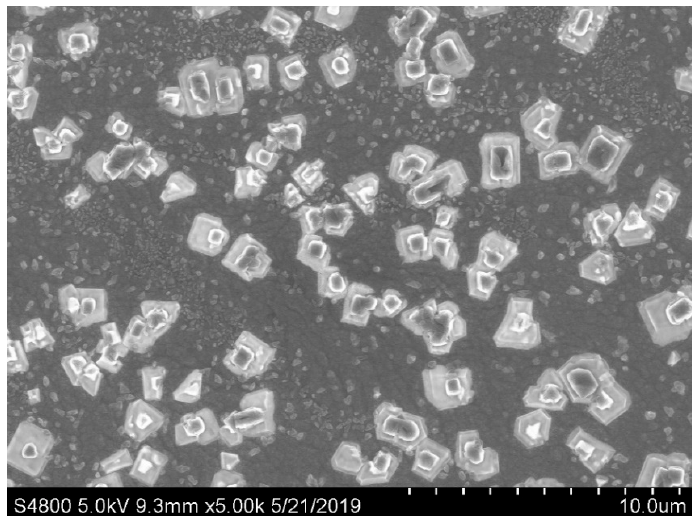
Figure 7. SEM image of cholic conjugated chitosan derivative 3.